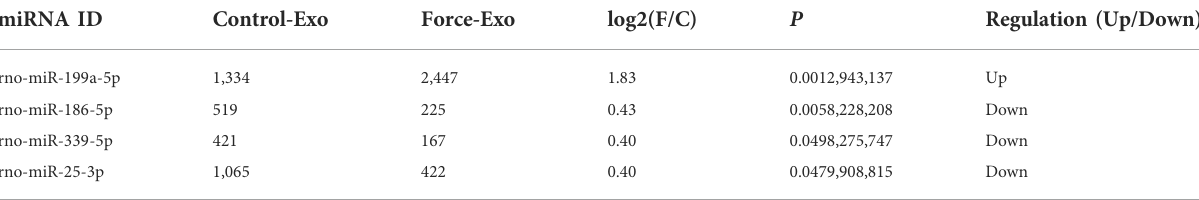
TABLE 1 miRNAs with signi fi cant differences in expression between the two MCC-Exo groups.